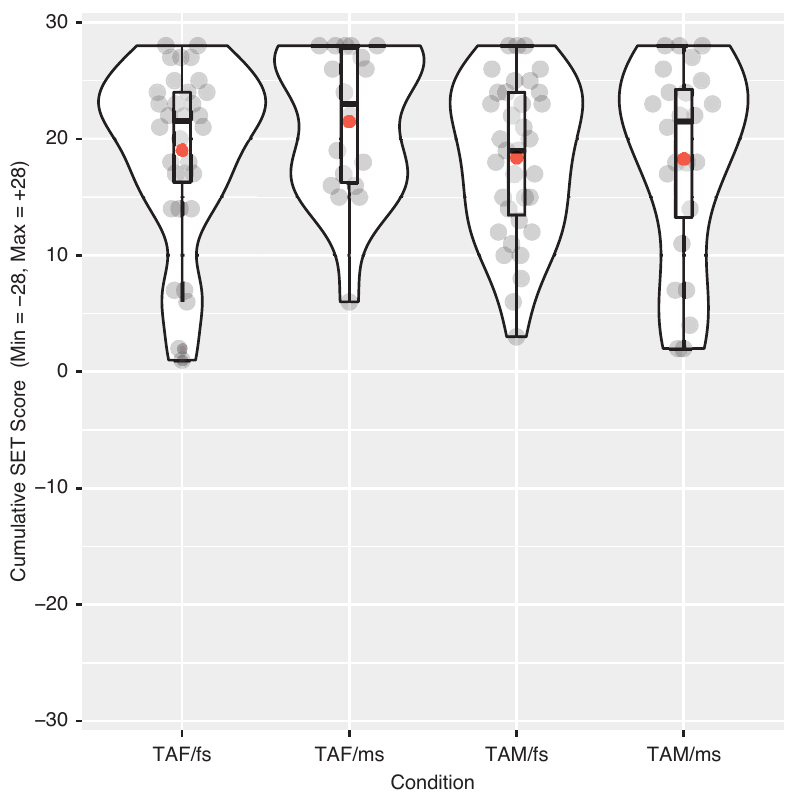
Figure 4. The violin plots of cumulative SET scores with the six outliers removed. The means in the two female TA conditions (TAF/fs, TAF/ms) are now higher than the means in the two male TA conditions (TAM/fs, TAM/ms), indicating that, if anything, female TAs get higher rating than male TAs. Similarly, the medians are also overall higher for the female TA than for the male